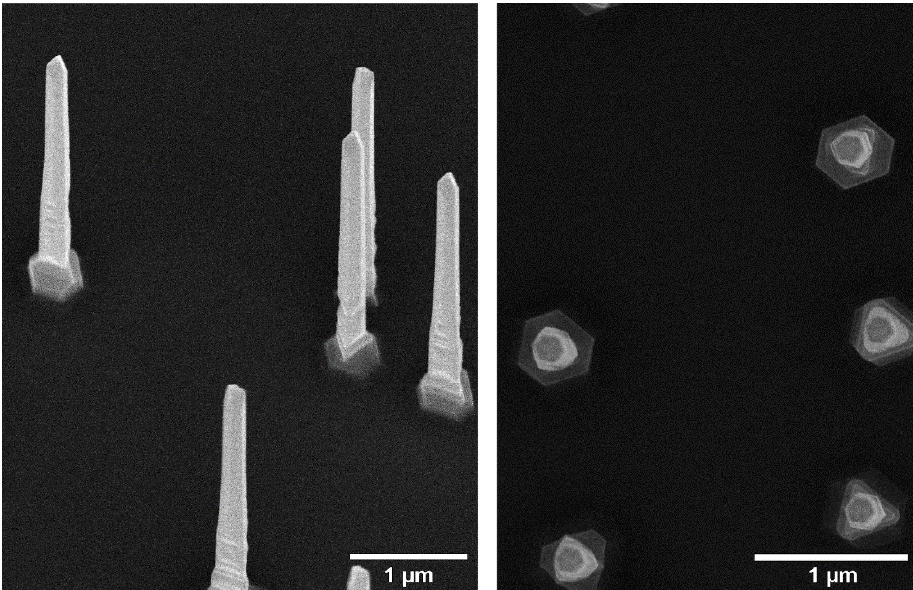
Figure 1. Scanning electron microscopy images of the GaP nanowires used in this study, taken at 30° and 0° stage inclination (perpendicular view).